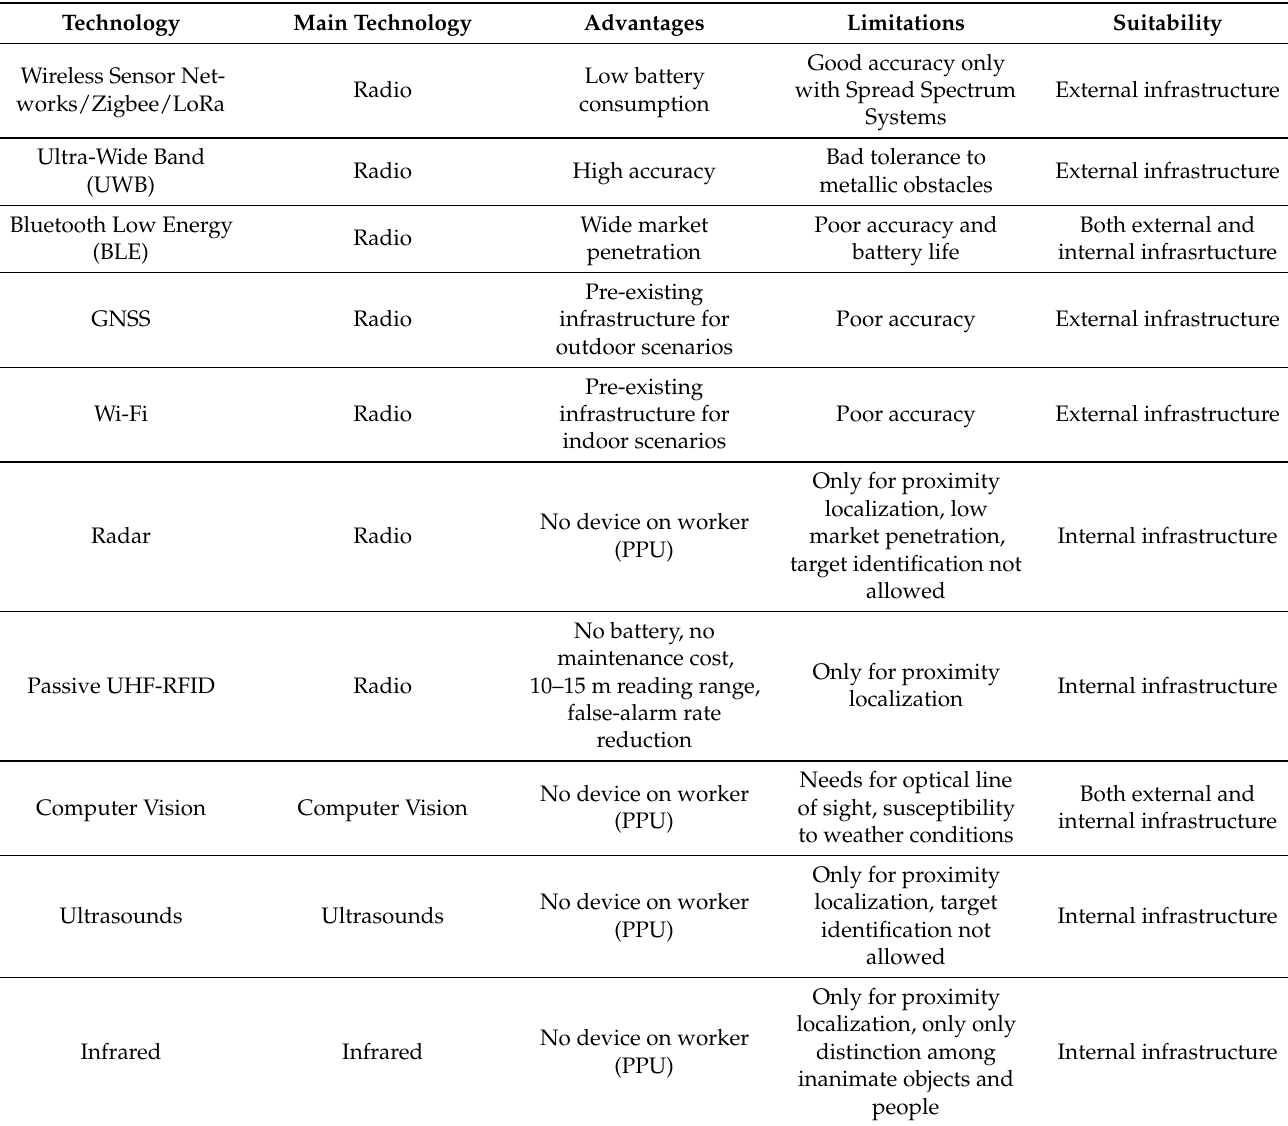
Table 1. Comparison among the various technologies available for RTLS for